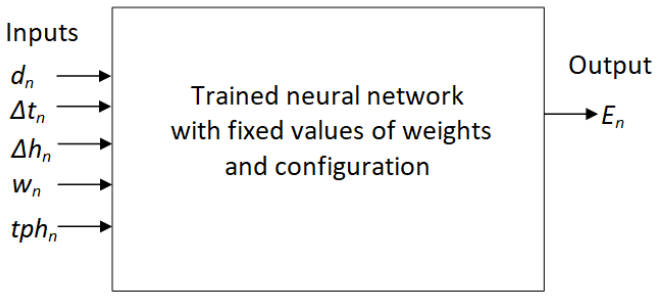
Figure 6. Neural model of energy consumption by an electric bus.